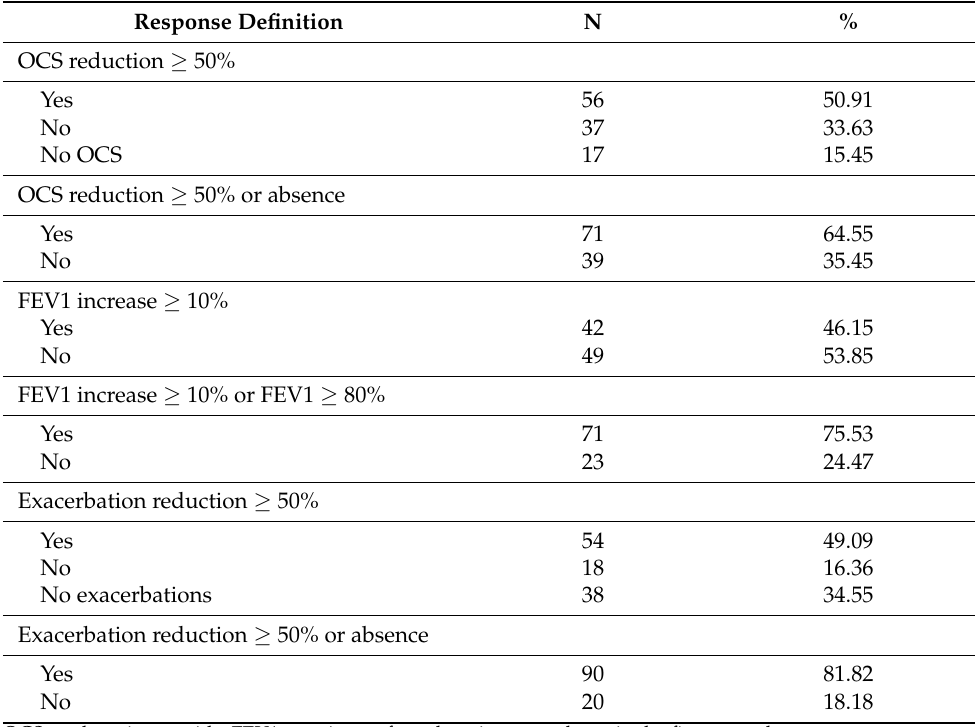
Table 2. Clinical efficacy of omalizumab in patients with severe uncontrolled